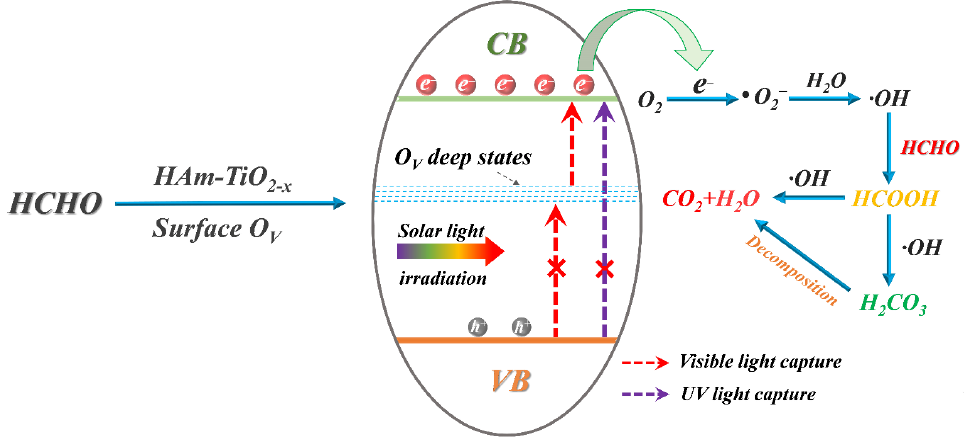
Figure 12. The proposed mechanism for photocatalytic elimination of HCHO with HAm-TiO 2 − x .